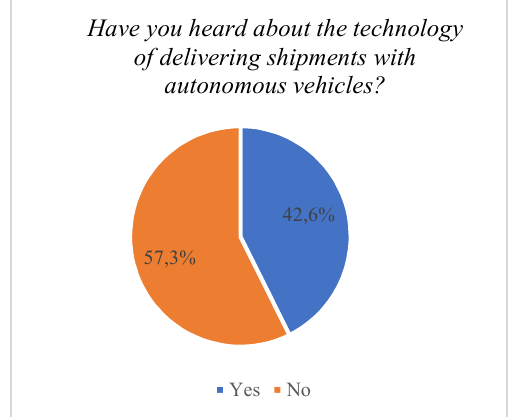
Figure 7. Question Results: Have you heard about the technology of delivering shipments with autonomous